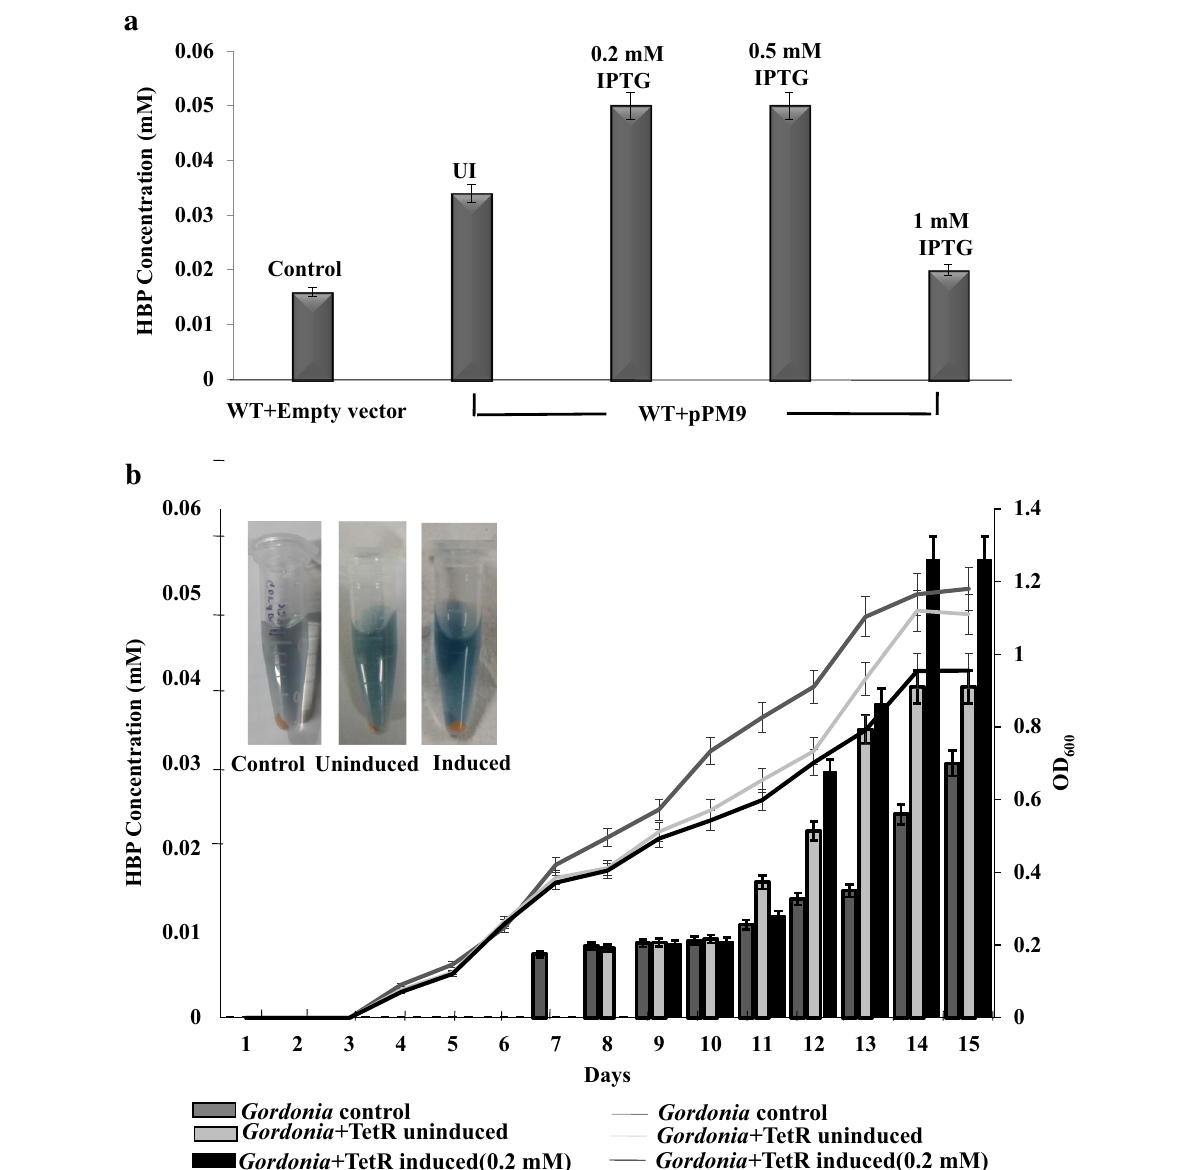
Fig. 5 Biodesulfurization activities in Gordonia sp. IITR100 when grown in DBT containing medium are enhanced when the TetR family protein is supplied in trans via plasmid. a Graph showing the effect of different inducer concentrations on the activity of dsz operon in Gordonia . UI corresponds to uninduced samples. b Graph showing an increase in activity of the dsz operon when the TetR family protein is induced with 0.2 mM IPTG. The bars represent 2 HBP concentration and the lines represent